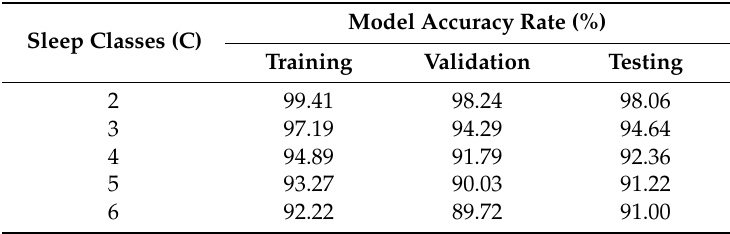
Table 8. Performance values using sleep-edf data of the models featuring two to six-classes of sleep stages with a single-channel EEG + EOG signal.